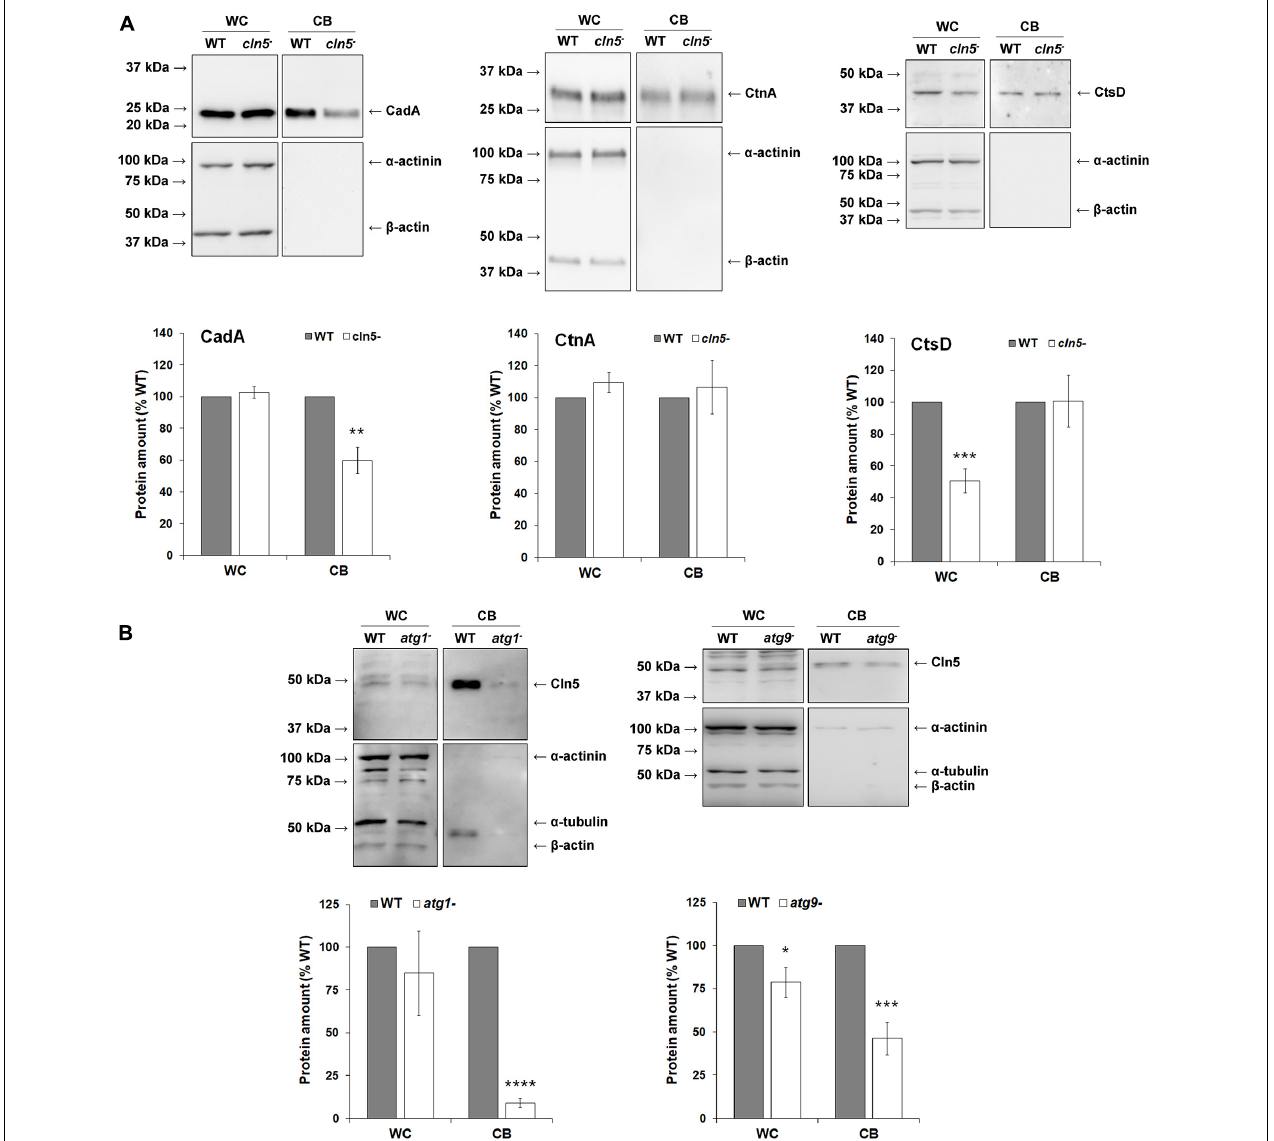
FIGURE 7 | Examining the role and secretion of Cln5 during aggregation. (A) Effect of cln5 -deficiency on the intracellular and extracellular amounts of CadA, CtnA, and CtsD during starvation. WT and cln5 − cells were starved for 4 h in KK2 buffer after which time the cells were lysed. Whole cell (WC) lysates (25 µ g) and conditioned buffer (CB, 0.25 µ g) were separated by SDS-PAGE and analyzed by western blotting with anti-CadA, anti-CtnA, anti-CtsD, anti-alpha-actinin (loading control), and anti-beta-actin (loading control). Molecular weight markers (in kDa) are shown to the left of each blot. Protein bands were quantified and standardized to the levels of alpha-actinin and beta-actin. Raw values were then expressed as a percentage of the protein amounts in WT WC lysates and CB. Data presented as mean amount of protein (% WT) ± SEM ( n ≥ 7). Statistical significance was determined using the one sample t -test. ** p < 0.01 and *** p < 0.001 vs. WT. (B) Assessing the role of Atg proteins in Cln5 secretion. WT, atg1 − , and atg9 − cells were starved for 4 h in KK2 buffer after which time the cells were lysed. WC lysates (20 µ g) and CB (0.2 µ g) were separated by SDS-PAGE and analyzed by western blotting with anti-Cln5, anti-alpha-actinin (loading control), anti-alpha-tubulin (loading control), and anti-beta-actin (loading control). Molecular weight markers (in kDa) are shown to the left of each blot. Protein bands were quantified and standardized to the levels of alpha-actinin, alpha-tubulin, and beta-actin. Raw values were then expressed as a percentage of the amount of Cln5 in WT WC lysates and CB. Data presented as mean amount of protein (% WT) ± SEM ( n ≥ 4). Statistical significance was determined using the one sample t -test. *** p < 0.001 and **** p < 0.0001 vs. WT.